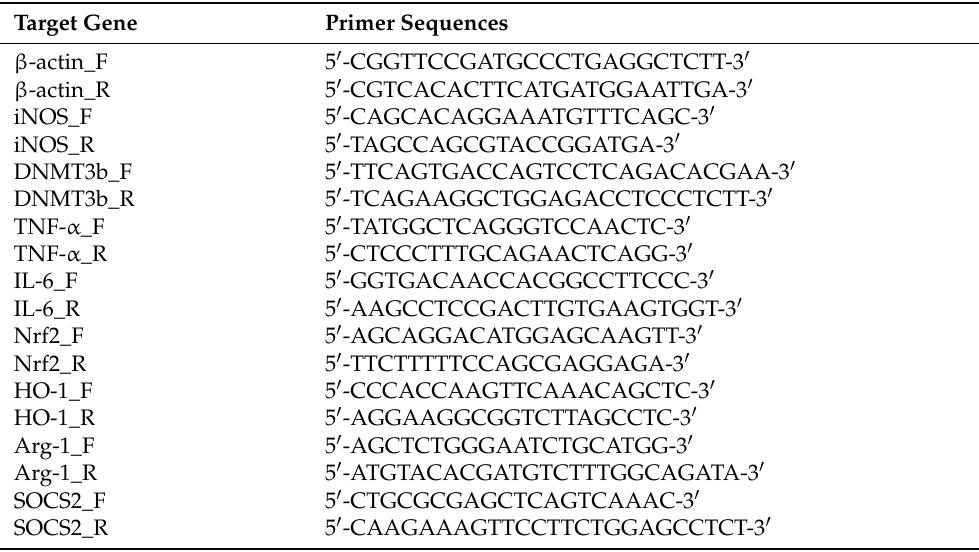
Table 1. The primers sequenses for